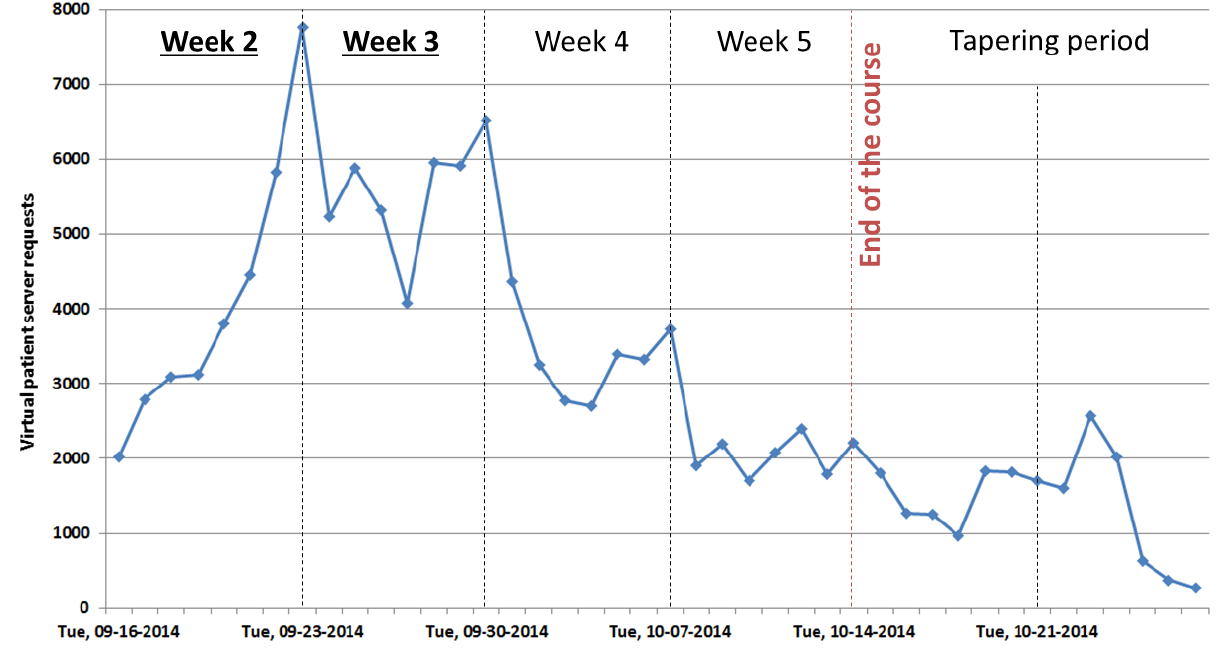
Figure 4. Virtual patient server requests per day in the Behavioral Medicine